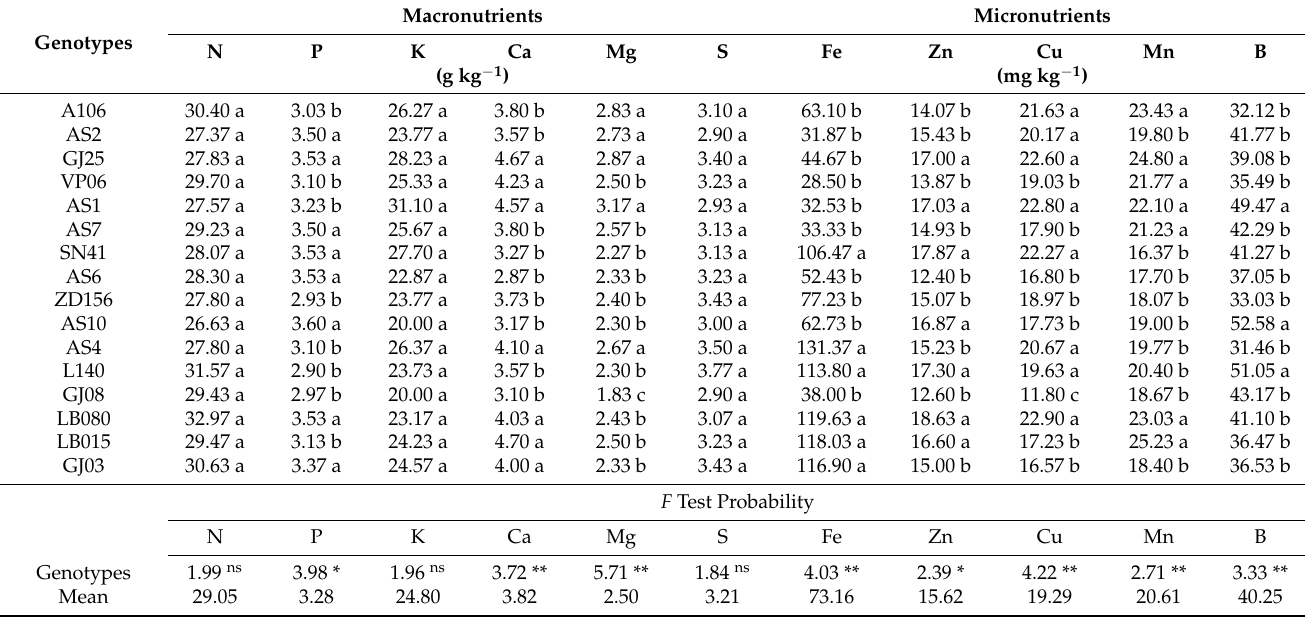
Table 5. Macro- and micronutrient concentrations of flowers of 16 Coffea canephora genotypes. Alta Floresta D’Oeste, Rond ô nia,